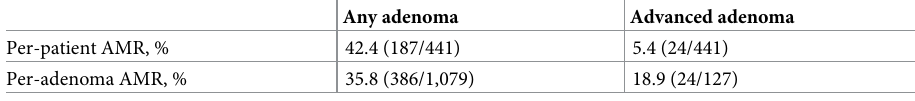
Table 2. Adenoma miss rate for any adenoma and advanced adenoma.